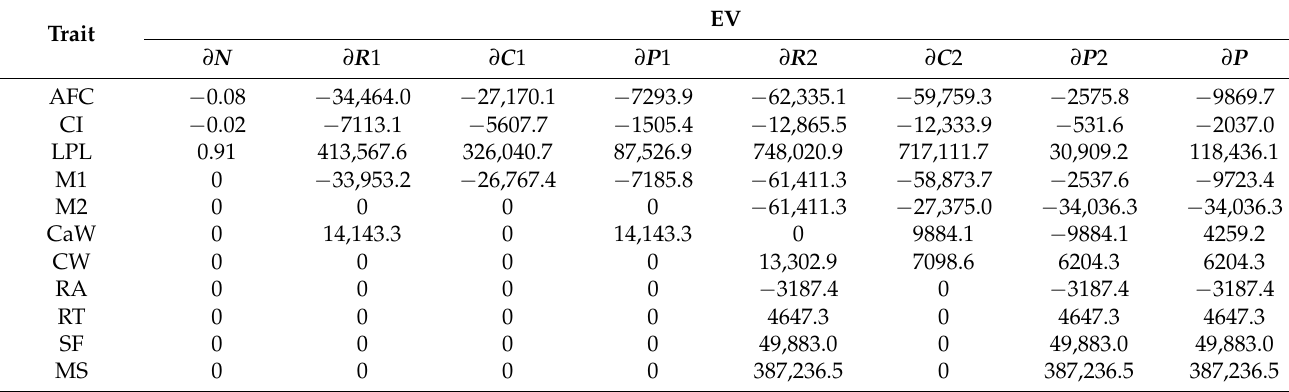
Table 5. Economic values (EVs) for the traits included in the profit function 1